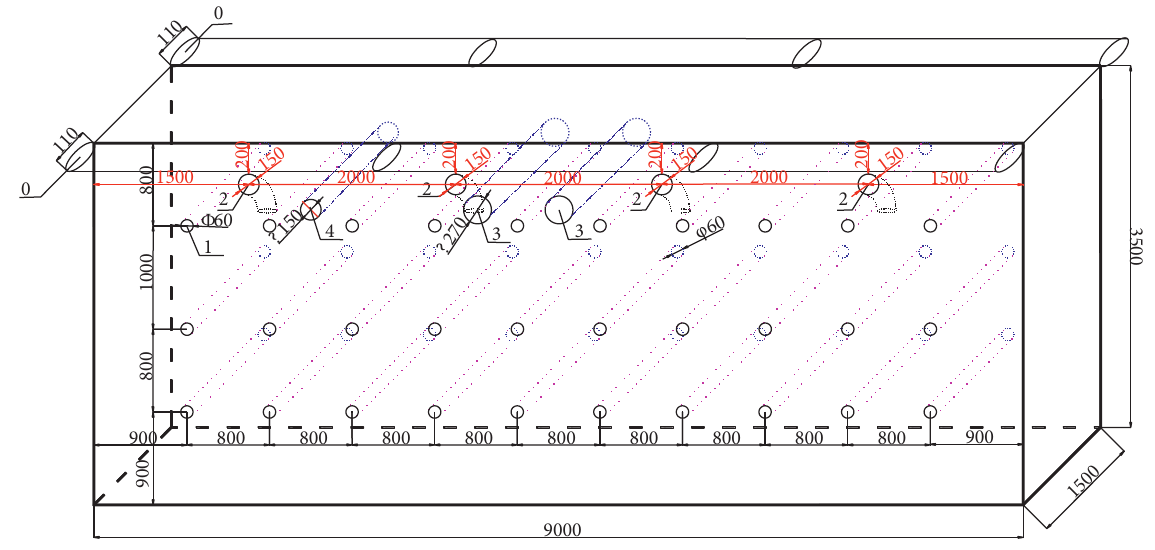
Figure 2: Schematic of the mold bag of the 9m section.